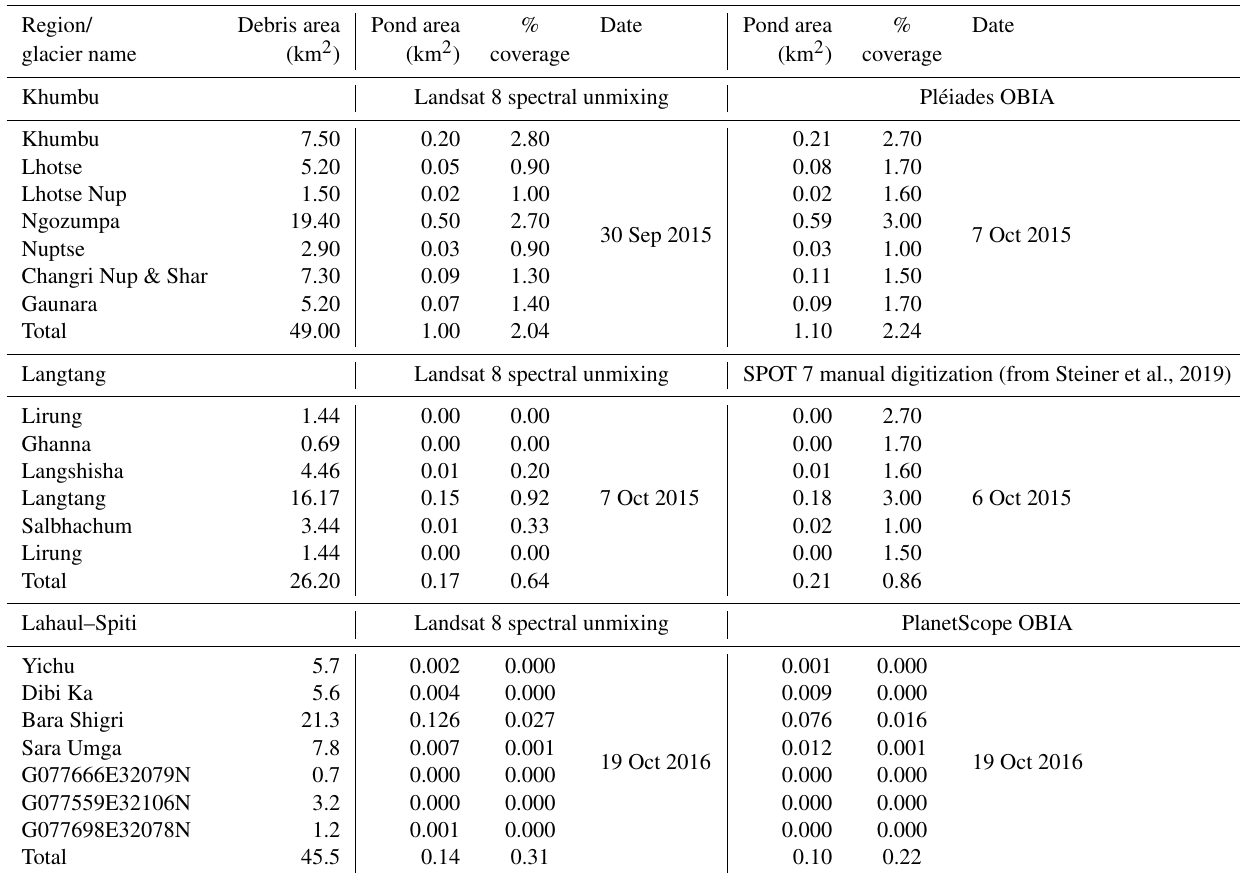
Table 4. Validation of the Landsat spectral unmixing for supraglacial pond coverage at selected glaciers at three sites across the Himalaya domain, shown in Fig.